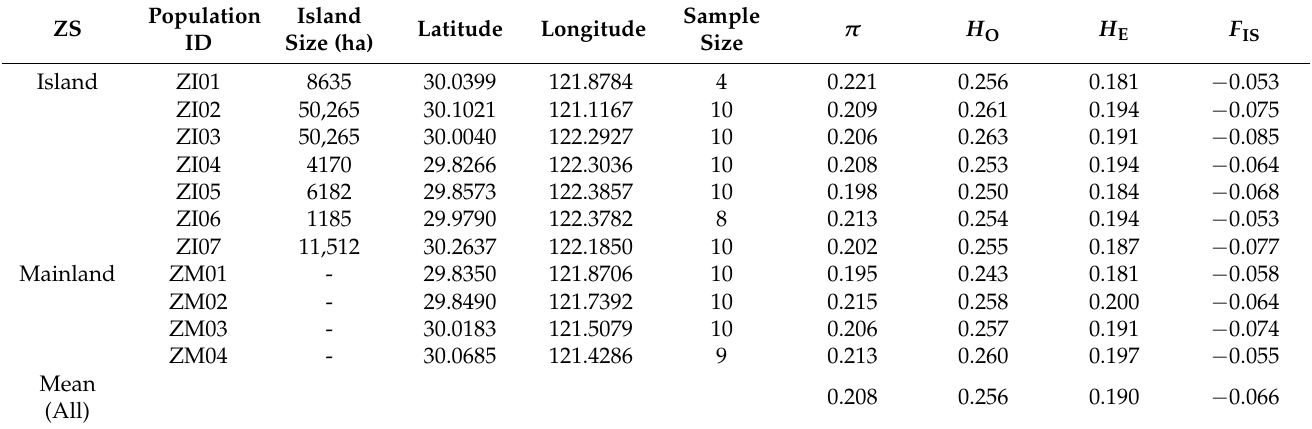
Table 2. Genetic characteristics of island and mainland populations of Hedyotis chrysotricha in the Zhoushan Archipelago (ZA)